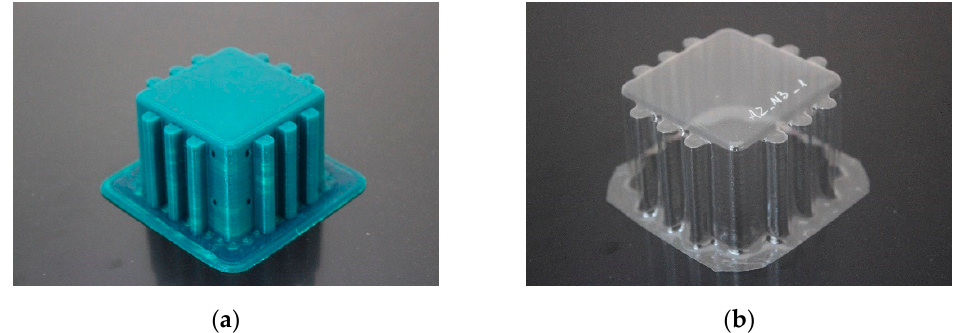
Figure 9. Example images of the results obtained: ( a ) mould A2_M3, ( b ) packaging created with mould A2_M3.